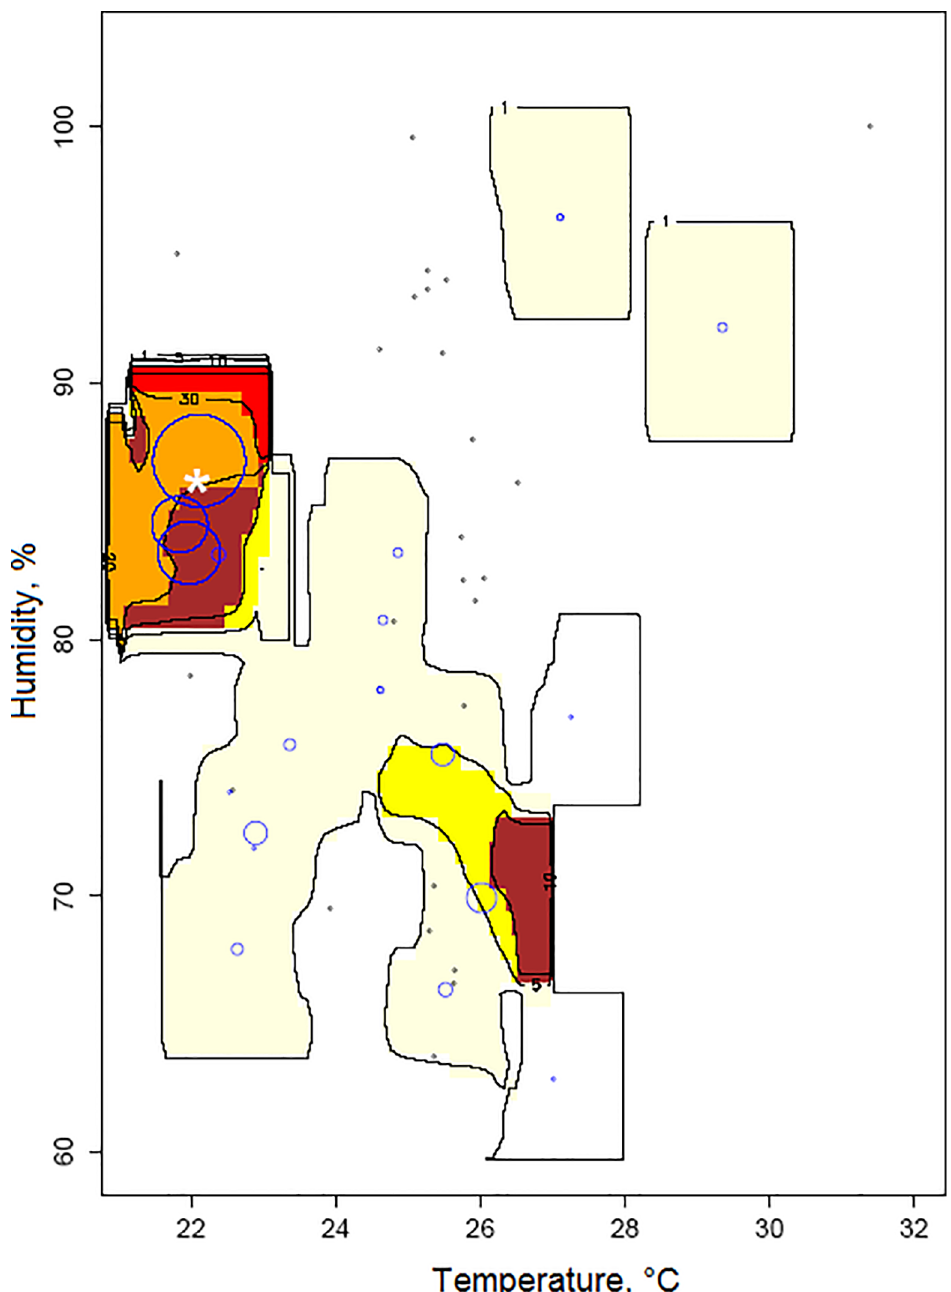
Fig 4. Within-crop distribution of thrips larvae in relation to the temperature and humidity. The size of circles corresponds to the number of larvae observed over the last three weeks. The * sign corresponds to estimated preferred climatic